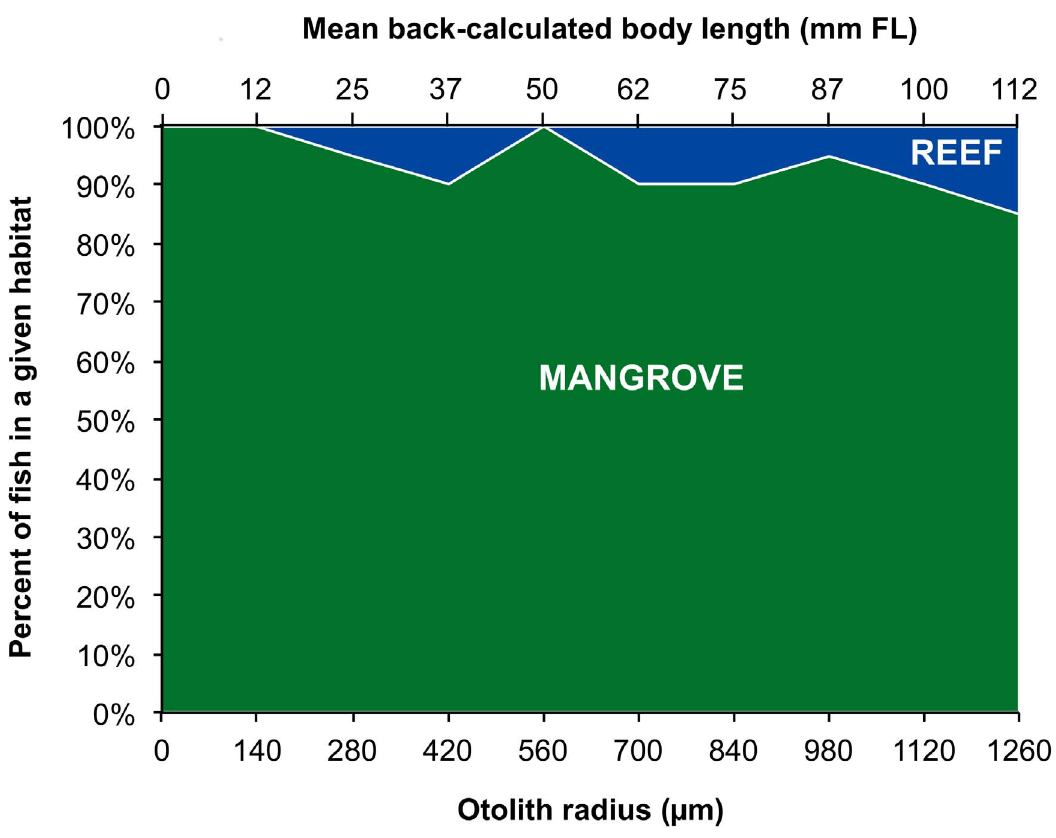
Figure 3. Proportion of adults L.fulviflamma occupying mangroves as juvenile. Results of RF prediction of habitats obtained along the juvenile part of otolith transects of the 20 adults L. fulviflamma collected in barrier reefs. For each fish and at each laser ablation along otolith transects, RF predict the habitat (mangrove or reef) corresponding to the chemical analysis. The green area represents the proportion of fish with a mangrove signature whereas the blue area represents the proportion of fish with a reef signature. Mean fish body length back-calculated from otolith radius are given in upper-x axis.